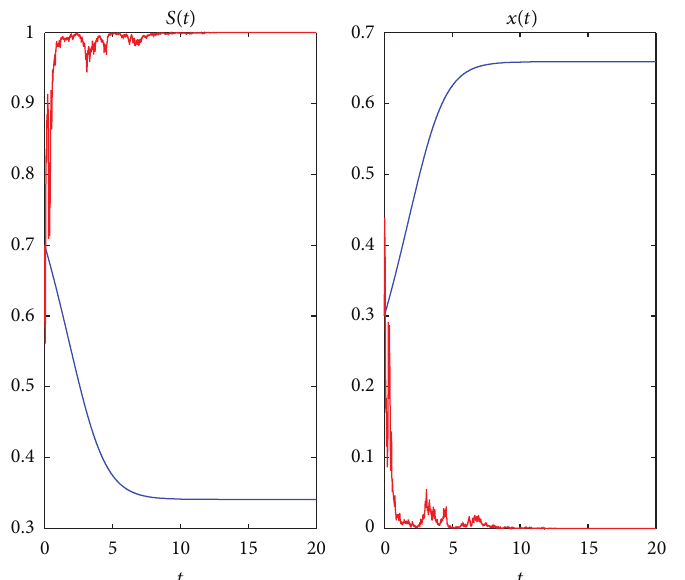
Figure 4: Deterministic and stochastic trajectories of chemostat model with Holling IV functional response function for initial condition = 0.7 ; 𝑥 = 0.3 ; and 𝑆 0 = 1 , 𝑚 = 2 , 𝑎 = 0.6 , 𝑏 = 0.4 , 𝐷 = 0.8 , and 𝛼 = 1.55 . 𝑆 0 0